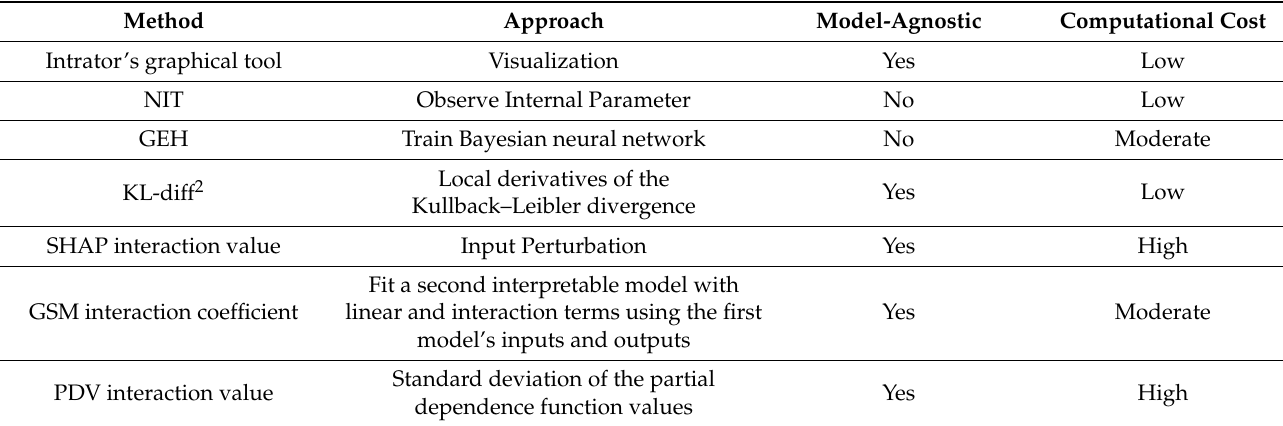
Table 1. Related works on methods for explaining covariate